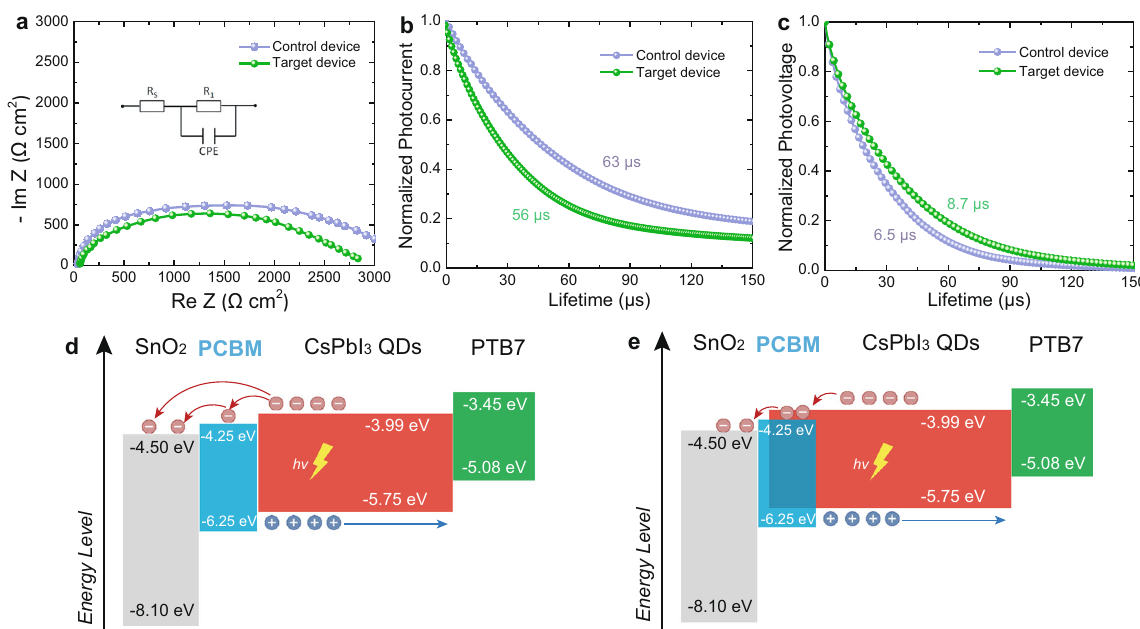
Fig. 3 Characterization of QD solar cells. a EIS curves of champion control and target devices (inset: equivalent circuit). b , c TPV and TPC curves in champion control and target devices. d , e Band energy level diagram of the control and target